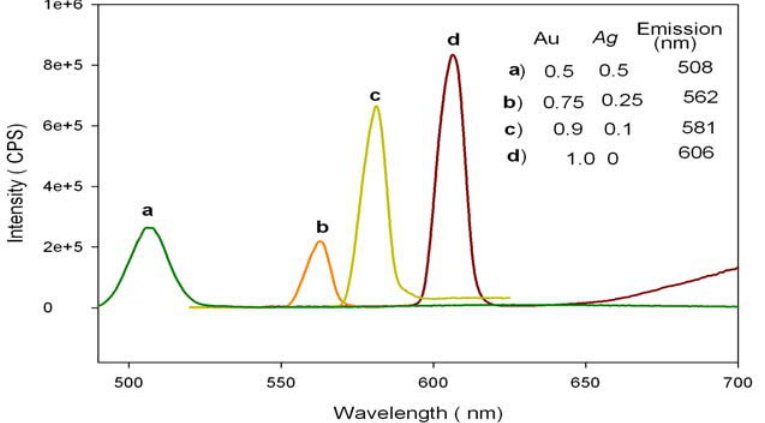
Figure 3 . Emission spectra of Au and Ag-Au alloy (Au mole fraction: 0.5, 0.75, 0.9 and 1) nanoparticles with varying Au mole